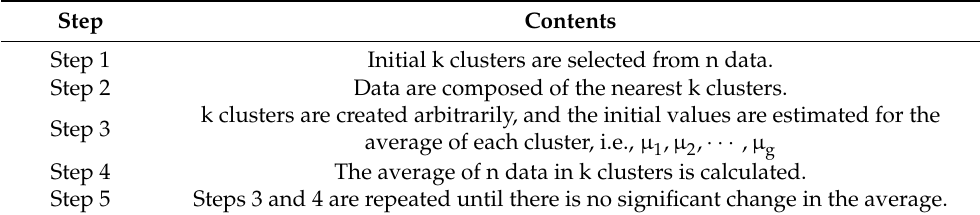
Table 2. Cluster analysis